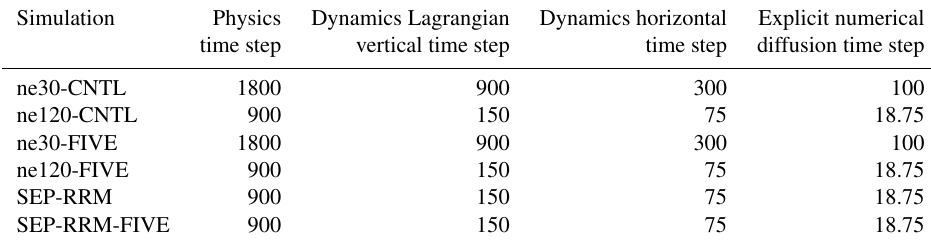
Table 2. Description of the time steps used in each simulation. Simulation